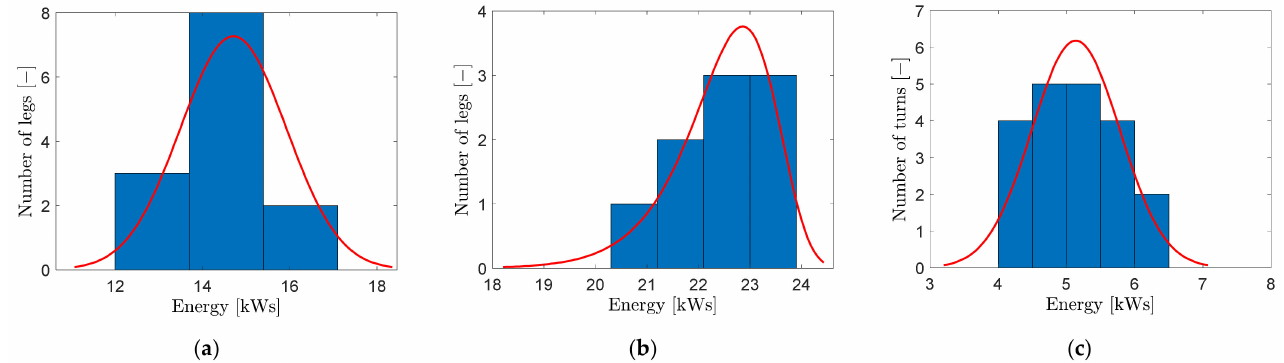
Figure 22. Histogram and probability distribution fit of ( a ) the N–S leg ( b ), the E–W leg, and ( c ) turn (real data).